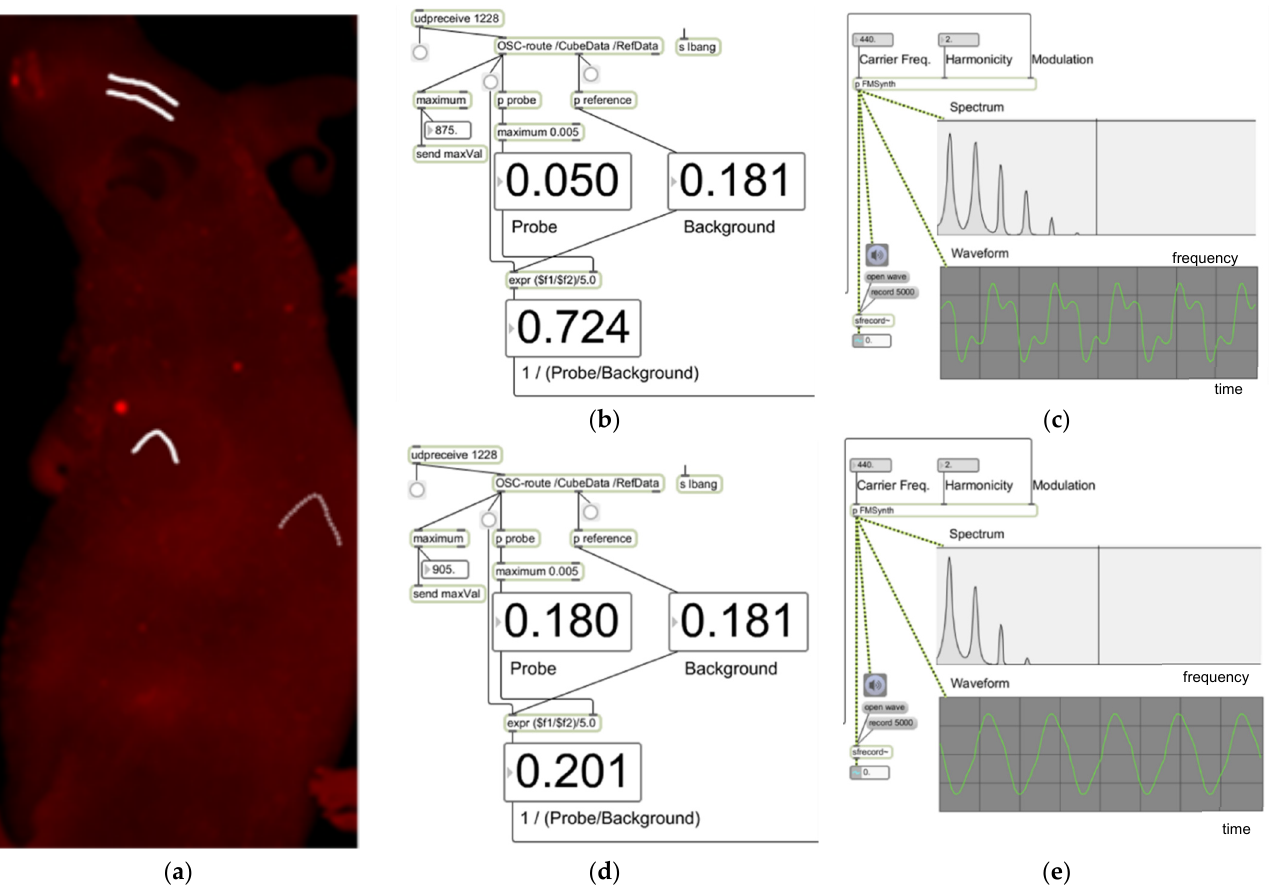
Figure 3. Samples of a session of auditory display. Shown in ( a ) is the navigation map (JPEG picture of a mouse during an image session). The tumor area is indicated by a single white curved line, the background skull by double white lines, and the non-tumor body by a dotted line. The rest of the figure depicts parameters for sonification as well as the spectrum/waveform of the resulting sounds from the tumor area ( b , c ), and those of the non-tumor area ( d , e ).